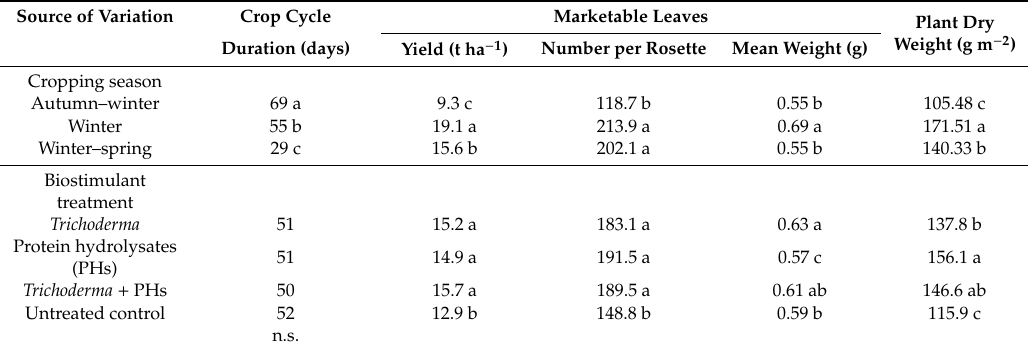
Table 1. E ff ect of cropping seasons and treatments with three biostimulants on the marketable production parameters of perennial wall rocket leaves and on plant dry